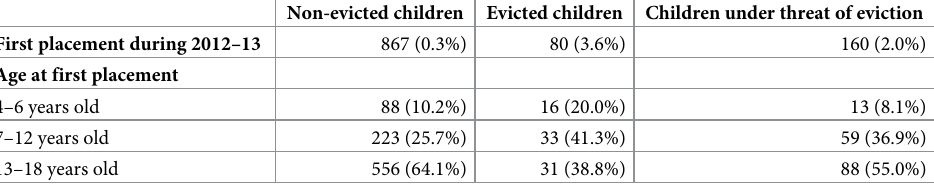
Table 3. Out-of-home care in 2012–2013.